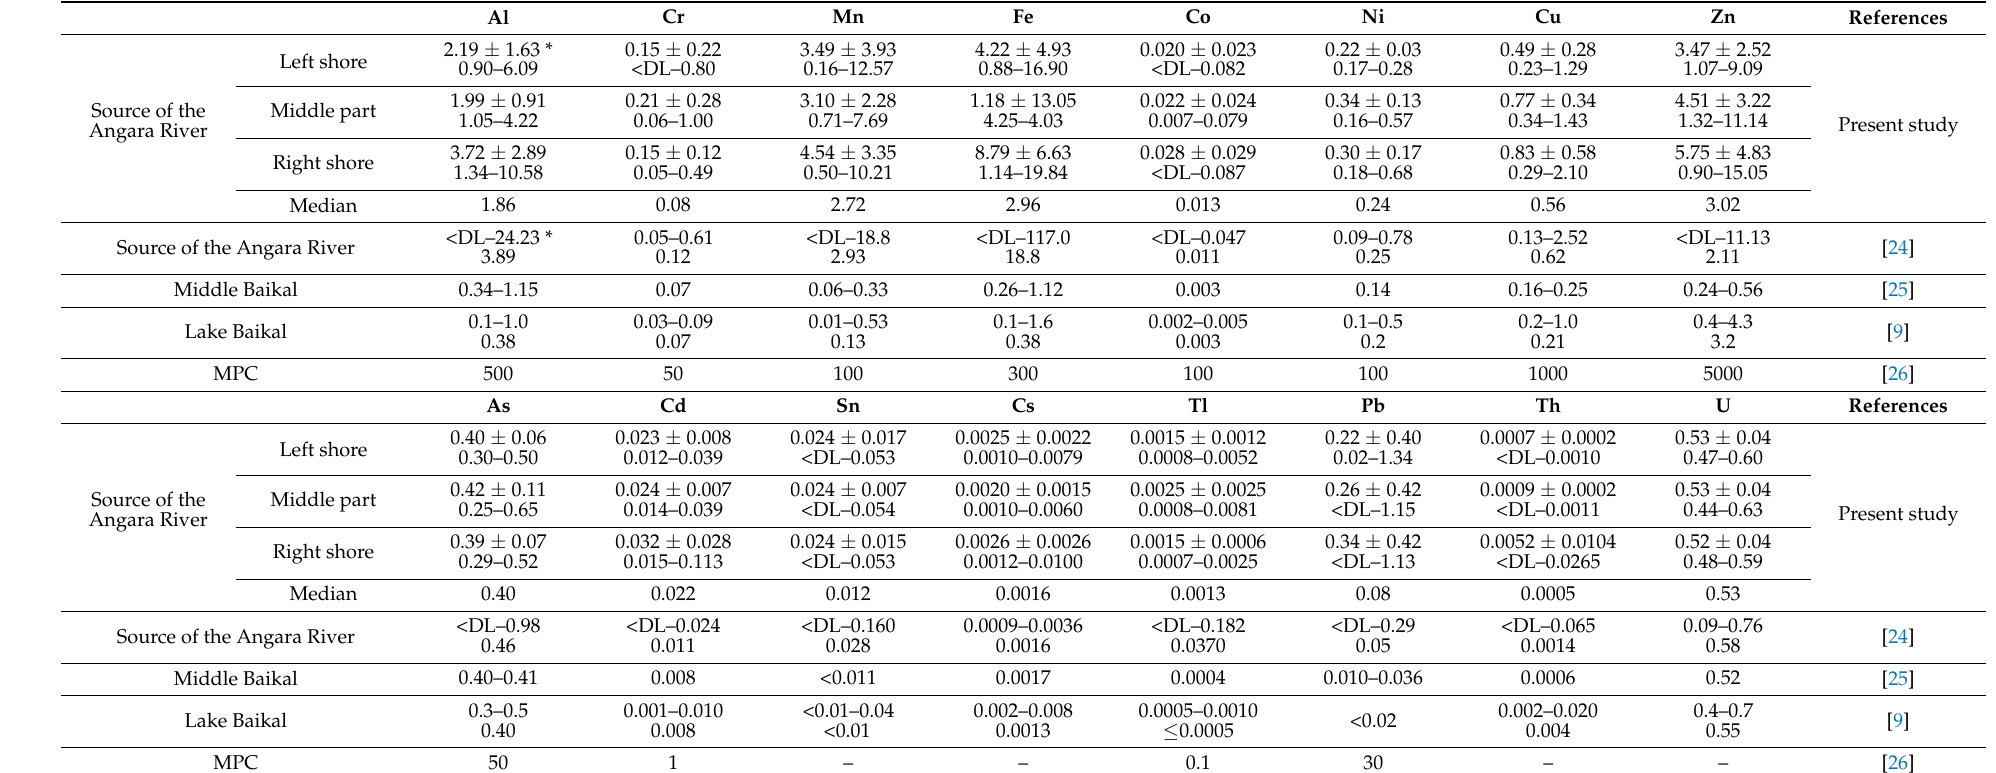
Table 1. Trace element concentrations ( µ g L − 1 ) in the water of Angara River